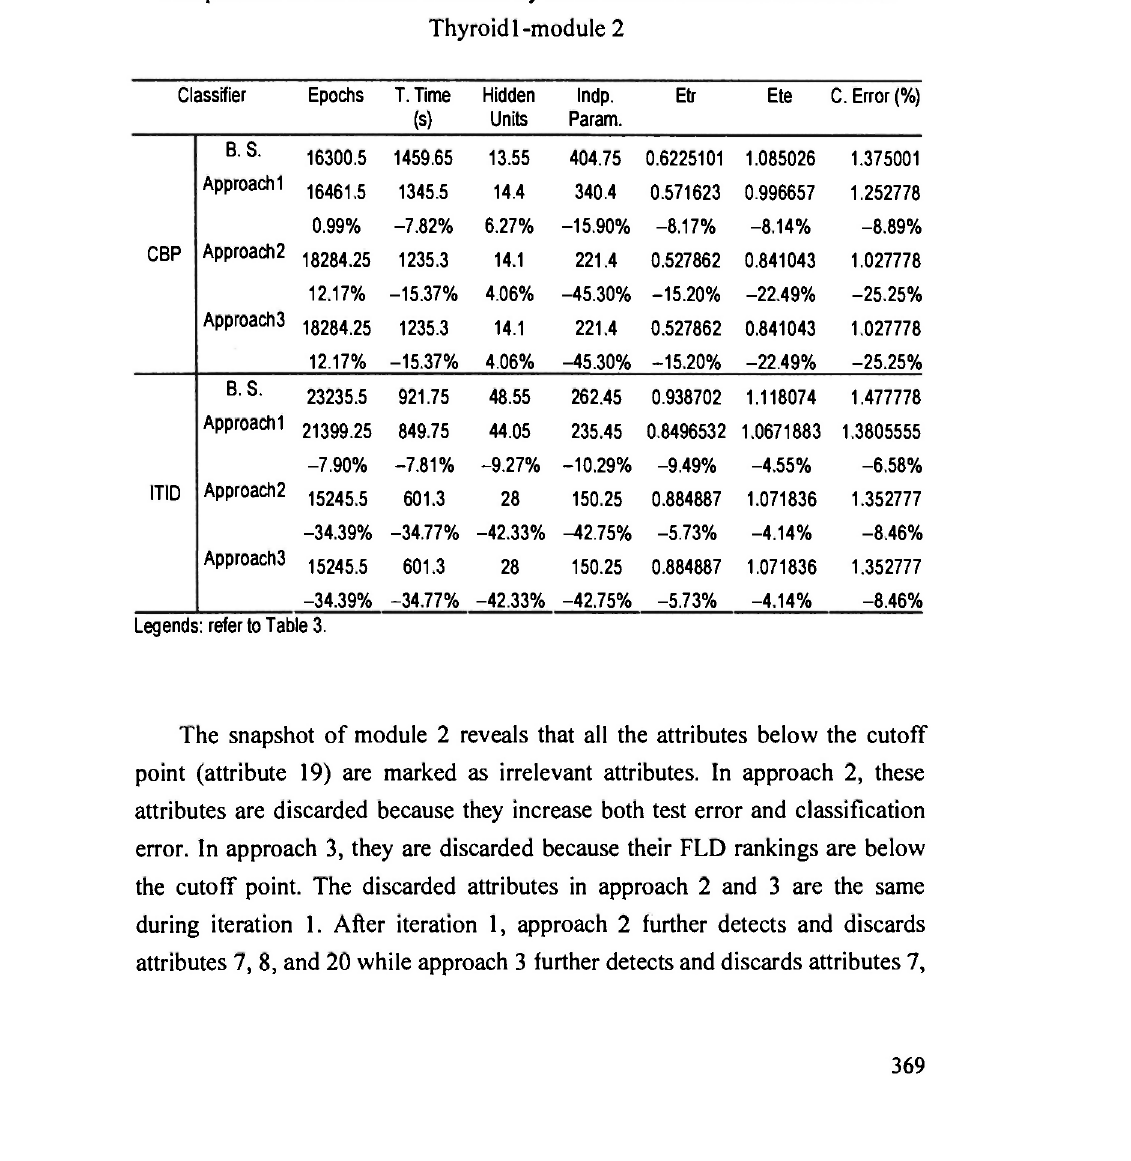
Comparison of the results obtained by three feature selection methods for Thyroid 1-module 2